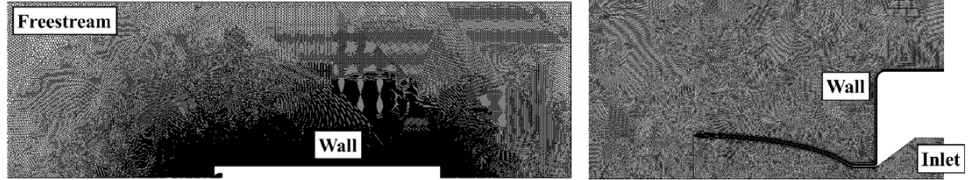
Figure 5. Mesh and boundary condition and mesh configurations. Table 6. Boundary condition of reference [23].